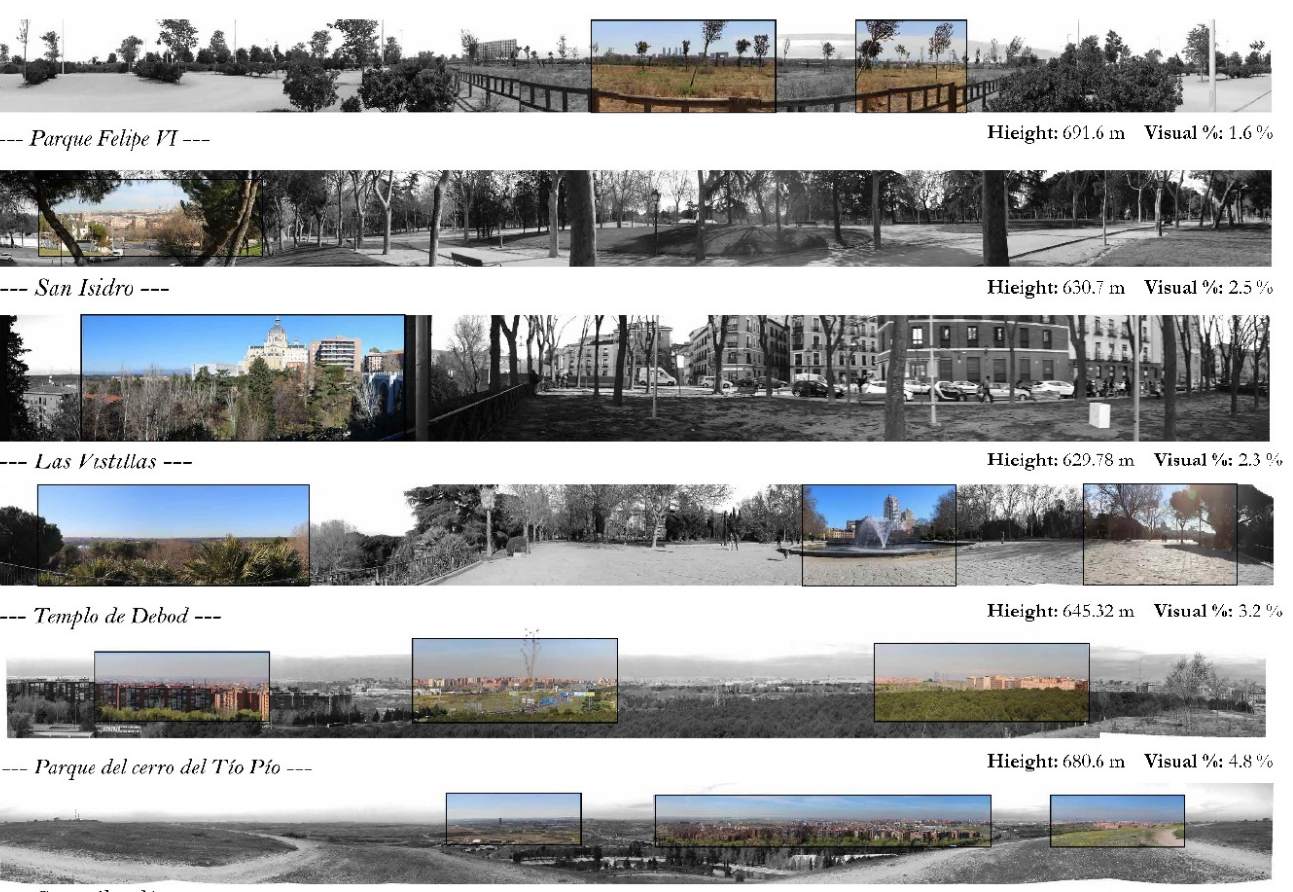
Figure 5: Examples of 360º panoramas taken during fieldwork, showing the selection of the most relevant frames in each one for their further analysis.